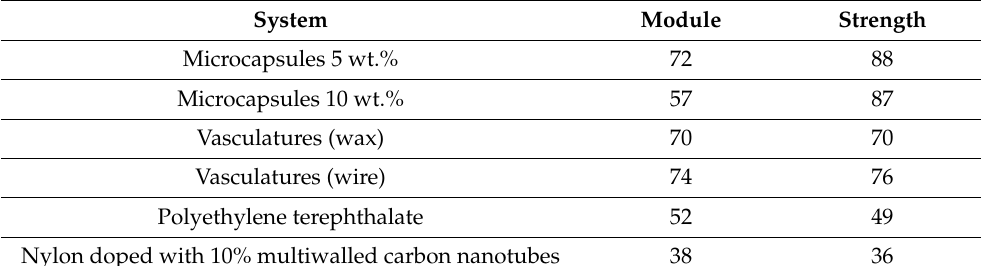
Table 1. Self-healing efficiency, %.